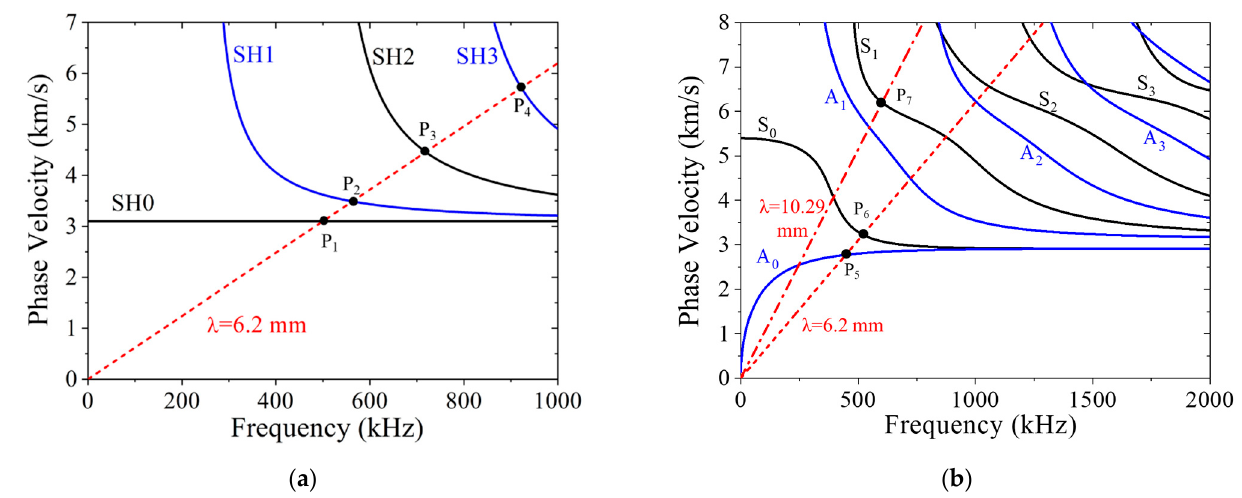
Figure 3. Phase velocity dispersion curves for guided waves in a 6-mm-thick aluminum plate with red activation line: ( a ) SH waves and ( b ) Lamb waves. The cross points are P1(500, 3.10), P2(563, 3.48), P3(713, 4.45), P4(922, 5.74), P5(447, 2.78), P6(520, 3.24), and P7(602, 6.19).